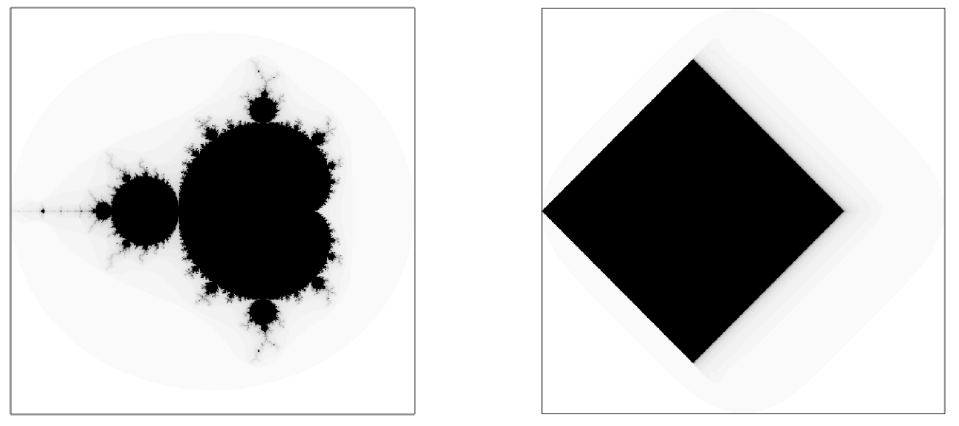
Figure 3. The standard Mandelbrot set (left) for i 2 = − 1 and the nonstandard set (right) for i 2 = + 1. Both sets are computed for x ∈ [ − 2,1 ] (horizontal axis) and iy ∈ [ − 1.5 i ,1.5 i ] (vertical axis) for a 10 3 × 10 3 grid and 100 iterations